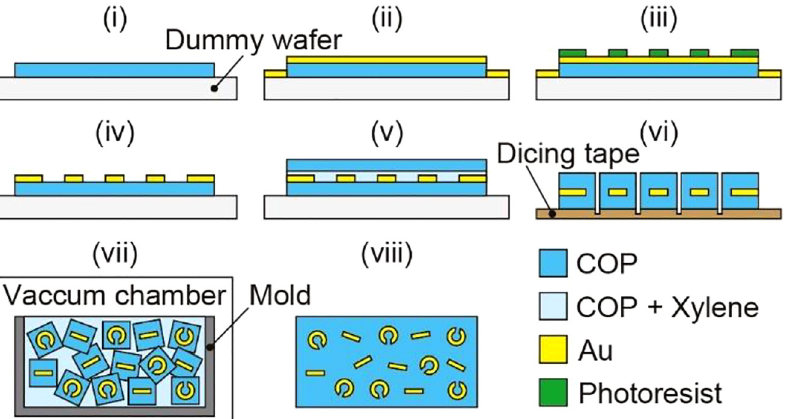
Figure 3: Fabrication processes for the proposed 3D bulk